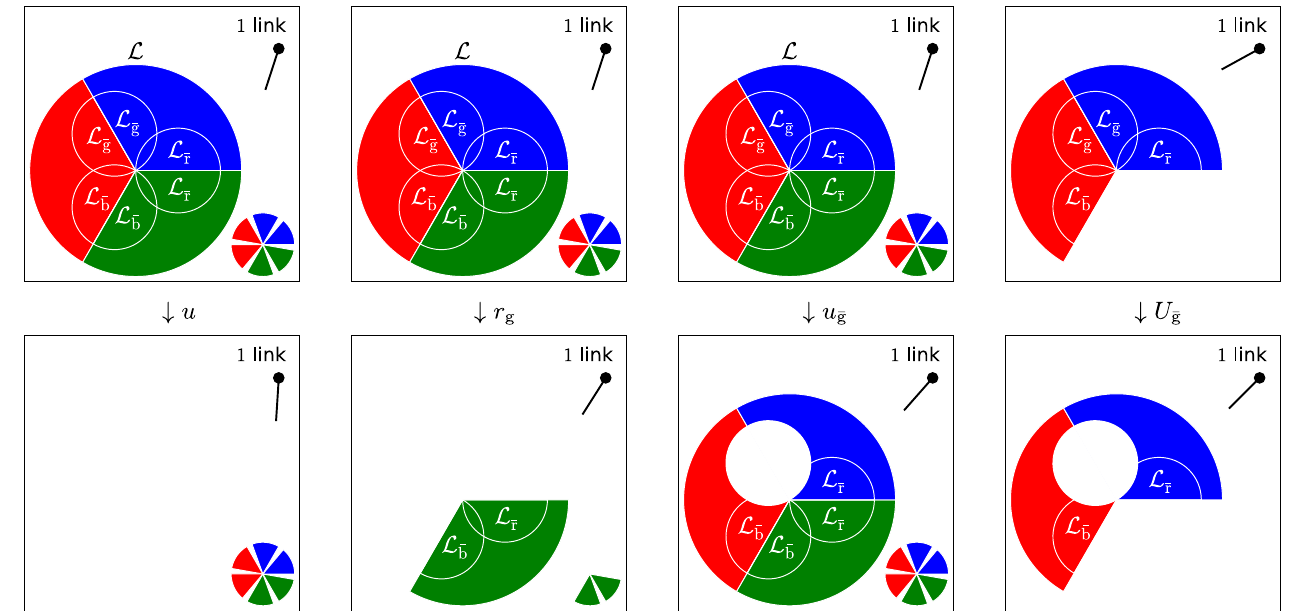
FIG. 9. Probabilities for a single link to connect to different parts of the network. We use these probabilities as primitives to calculate the probability for many links. While u , r , and u ¯ can be calculated with standard methods invented for the configuration model, the c c conditional probability U ¯ can be calculated as a combination of the others. c